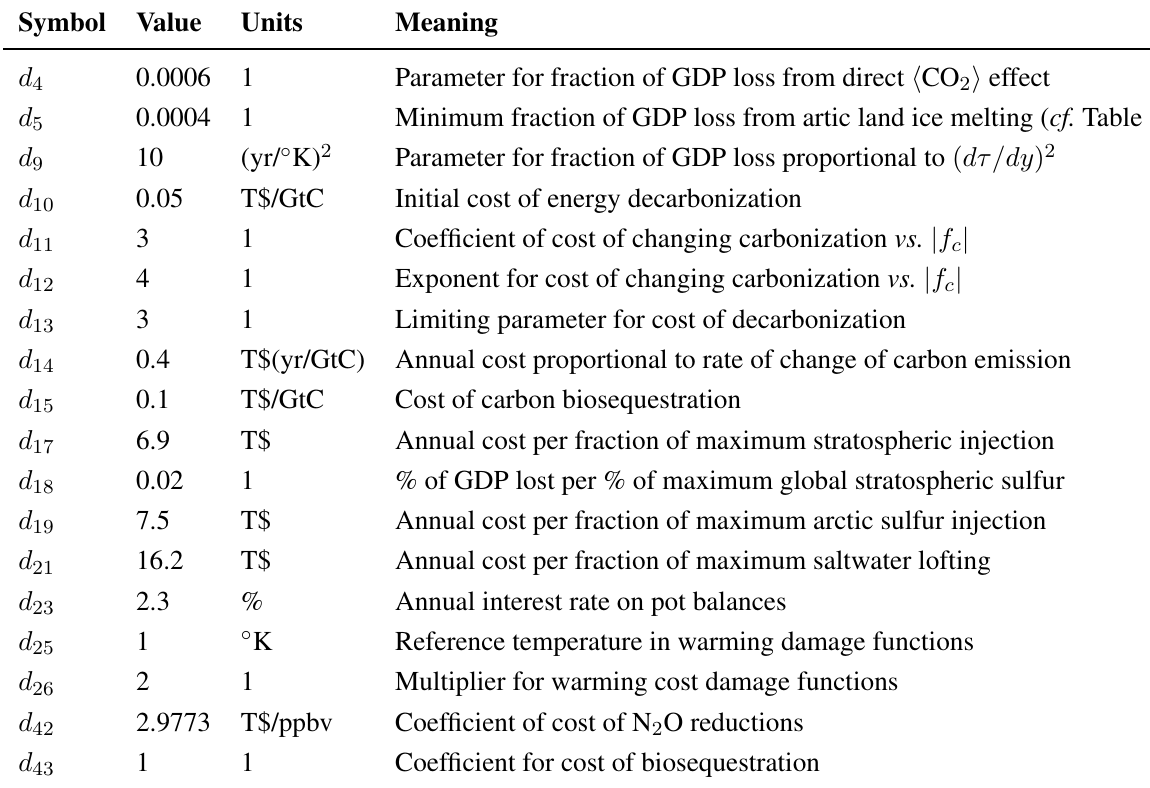
Table 7. Global financial